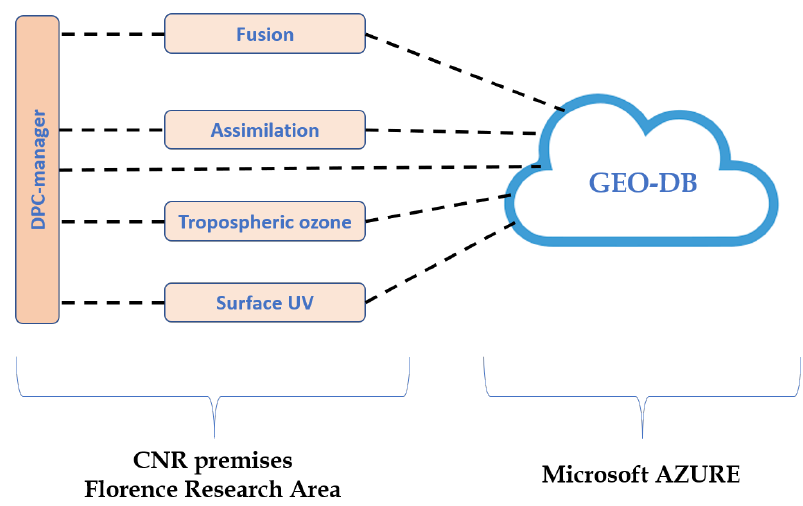
Figure 12. Assembly of the prototype for the processing